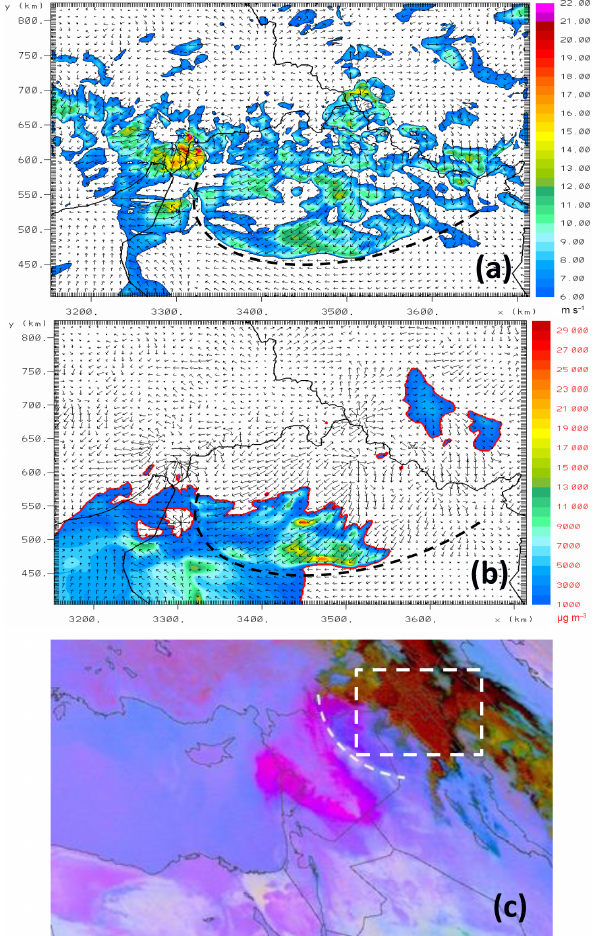
Figure 8. (a) Model wind speed greater than 6ms − 1 at 10m and (b) near-surface model dust concentration (µgm − 3 ) from the inner grid (2km × 2km). (c) MSG-SEVIRI RGB component on 6 September 2015, 20:00UTC. The dashed lines indicate the ha- boob front location, and the dashed rectangle in (c) approximately indicates the location of the model domains shown in (a) and (b) .